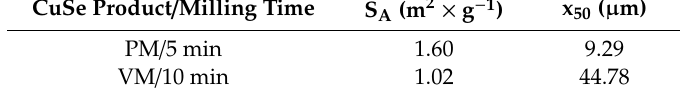
Table 2. Specific surface area, S A , and particle mean diameter, x 50 , of the final CuSe products. CuSe Product / Milling